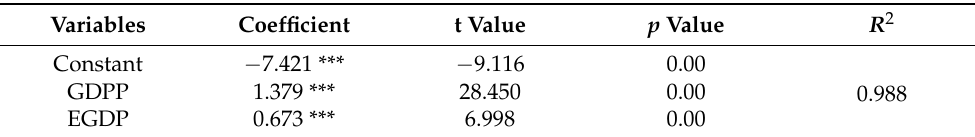
Table 7. The results of regression.